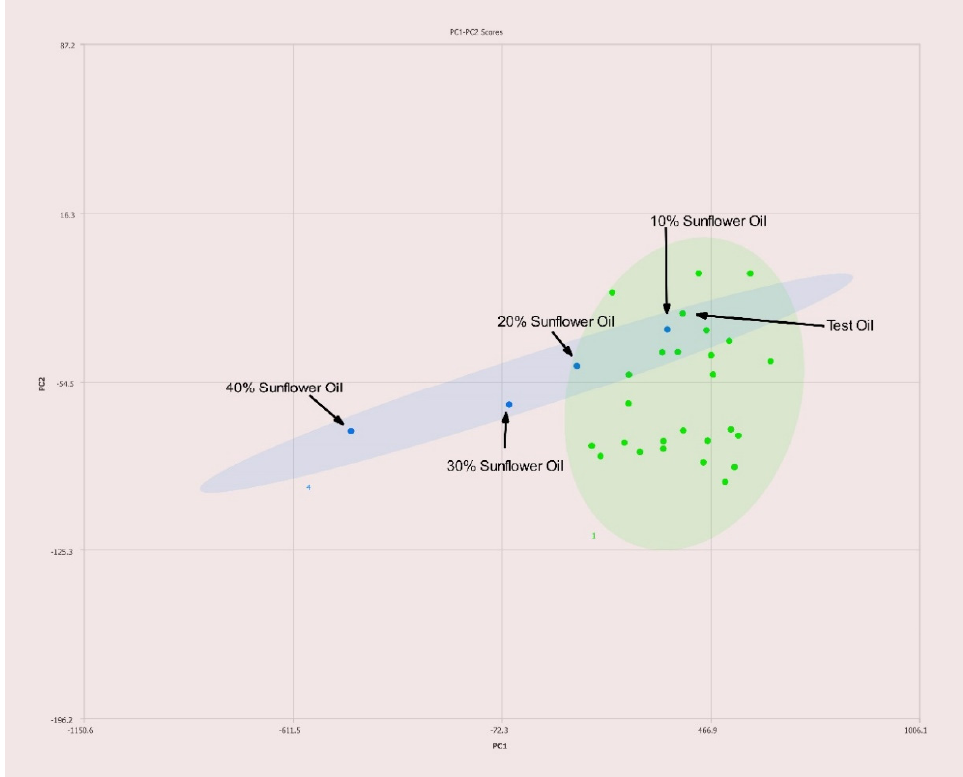
Figure 10. PC1–PC2 plot of 400 MHz 1H NMR spectra of olive oil adulterated with sunflower oil with percentages of adulteration noted. Ellipses represent the 95% confidence interval.